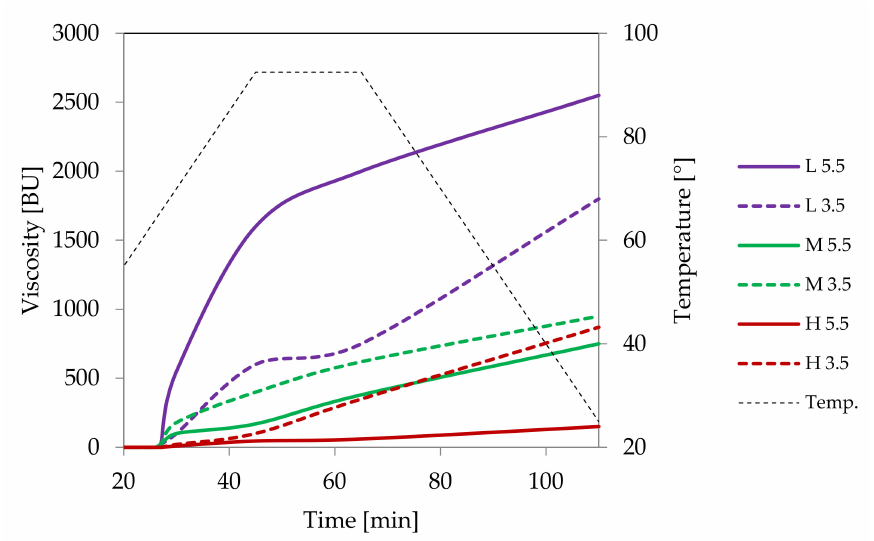
Figure 8. Pasting characteristics of samples of distarch phosphate of potato origin with di ff erent degrees of crosslinking (L–low, M–medium, H-high) recorded for dispersions in a concentration of 4.5% at pH = 5.5 or pH = 3.5.